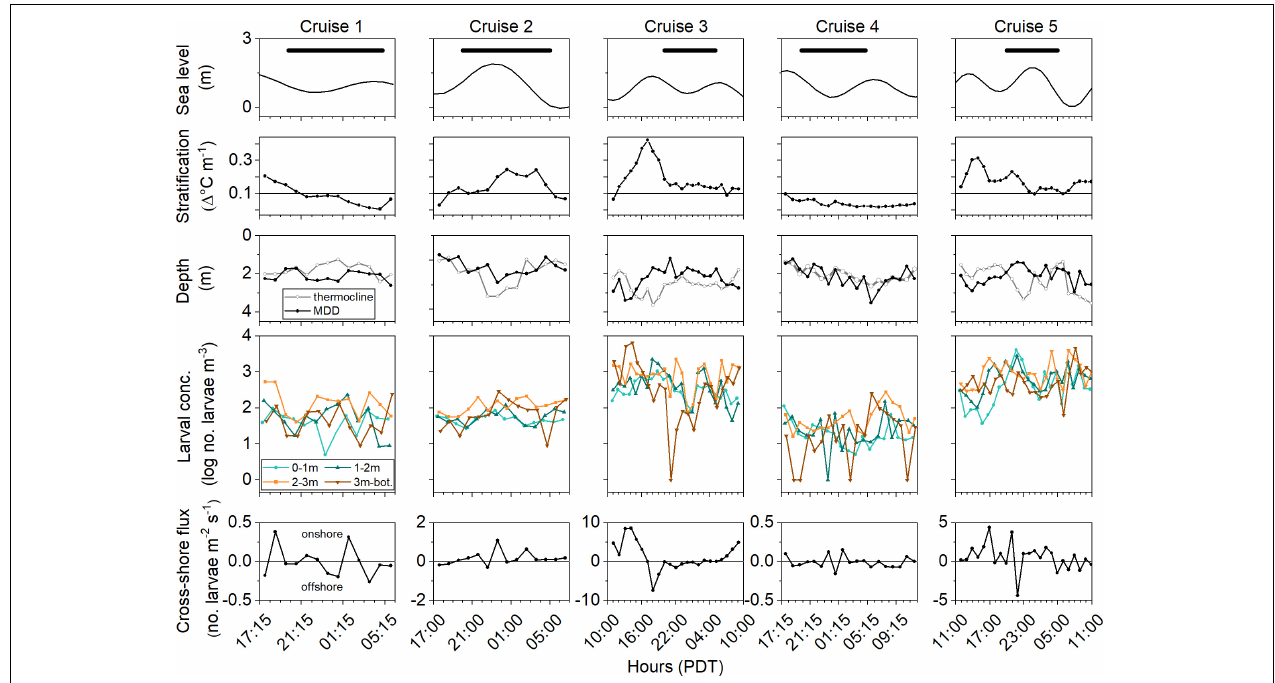
FIGURE 7 | Summary of physical conditions and larval parameters at the 4 m-deep plankton and CTD station during each cruise. Sea level (tidal height), thermal stratification from the CTD data, thermocline depth, C. fissus larval Mean Depth Distribution (MDD), larval concentrations by depth, and cross-shore larval flux (in rows) for all cruises (in columns). Black bars in sea level plots represent night-time sampling. Conditions are stratified when thermal stratification is ≥ 0.1 (cid:49) ◦ C m − 1 (shown as horizontal reference line in stratification plots). Positive values represent onshore (eastward) larval flux.